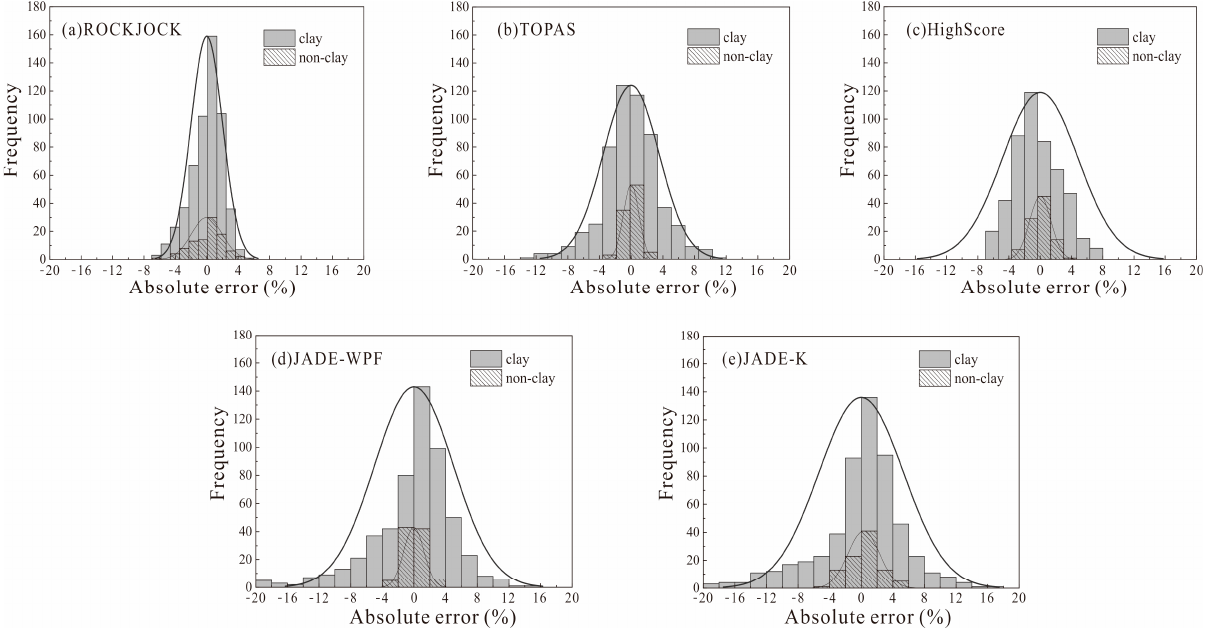
Figure 5. Absolute error frequency distribution of samples. ( a ) for FPS method by ROCKJOCK; ( b ) for Rietveld method by TOPAS; ( c ) for Rietveld method by HighScore; ( d ) for Whole Pa tt ern Fit- ting(WPF) and Rietveld Re fi nement by JADE; ( e ) for RIR method by JADE.